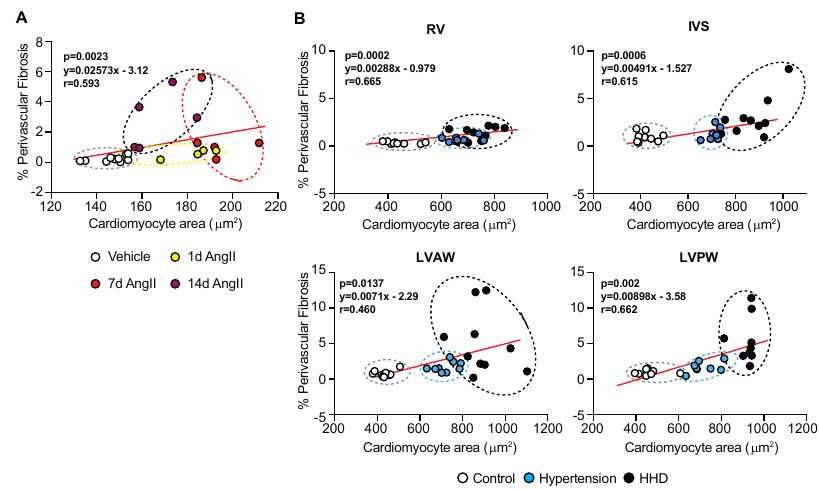
Figure 3. Cardiomyocyte size and perivascular fibrosis correlation with disease progression. ( A ) C57Bl/6J wild-type mice treated with Angiotensin II (AngII; 0.8 mg/kg/d) for up to 14 d. Correlation of cardiomyocyte cross-sectional area with perivascular fibrosis (as a percentage of total area). ( B ) Human post-mortem cardiac tissue with hypertension and hypertensive heart disease. Correlation of cardiomyocyte cross-sectional area with perivascular fibrosis (as a percentage of total area). Stats: Pearson correlation, with 2-tailed test reporting p -values.